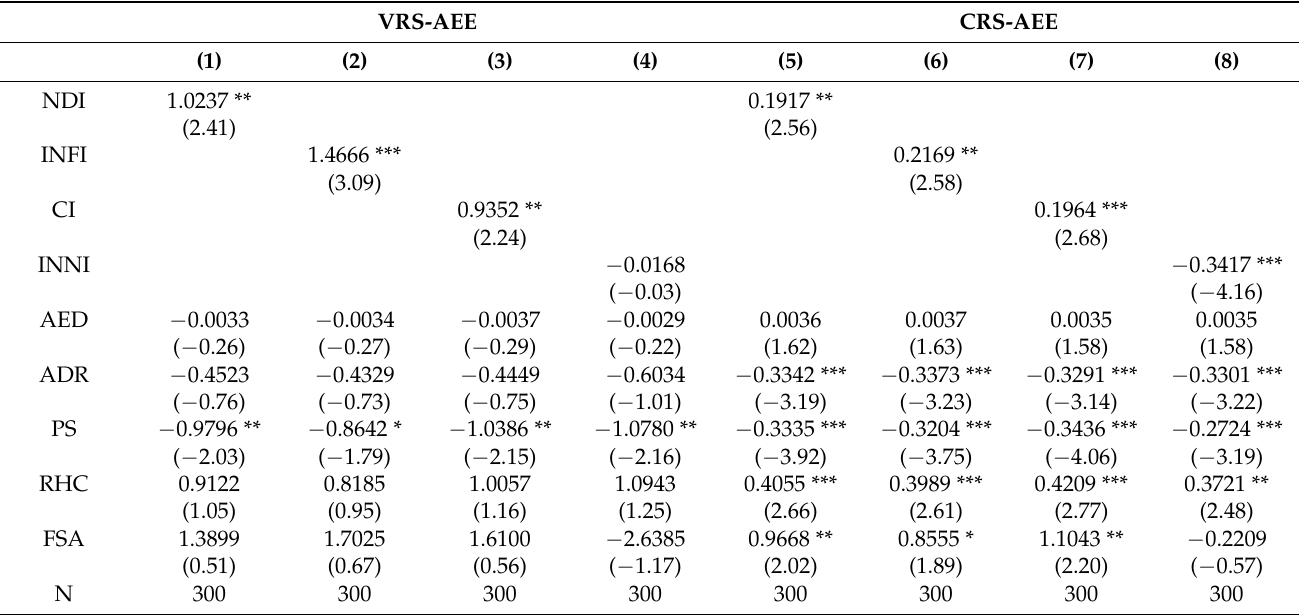
Table 6. Baseline regression